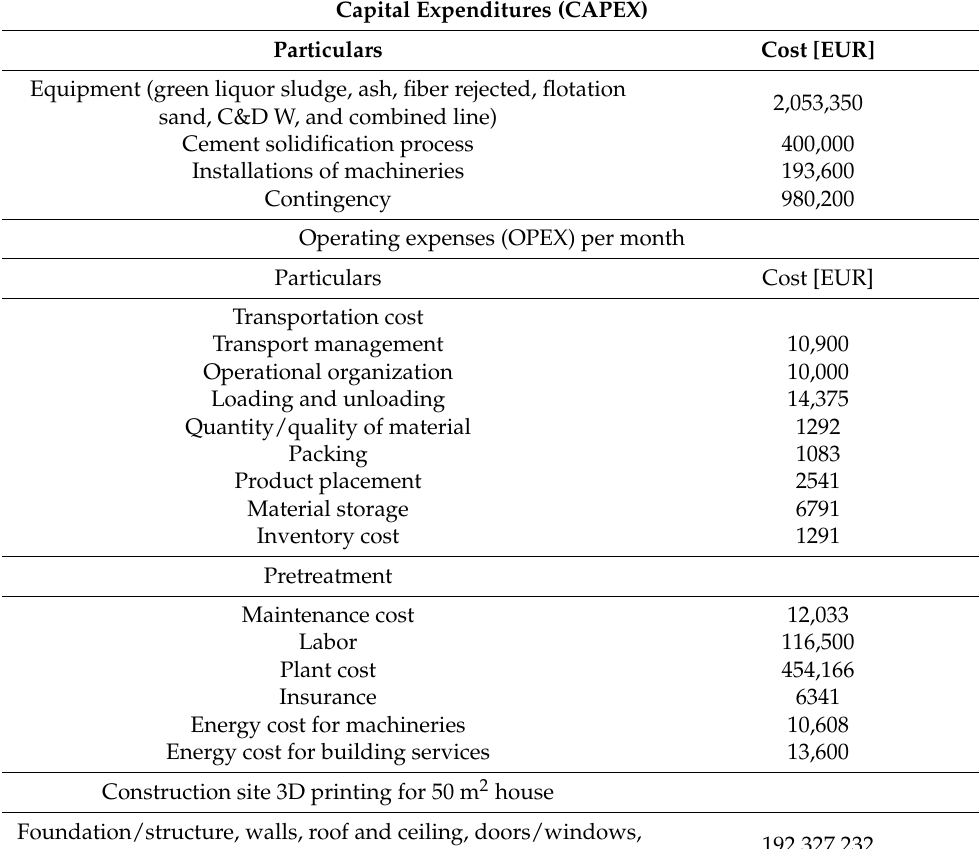
Table 11. Capital and operating expenditures needed for geopolymer 3D printing.